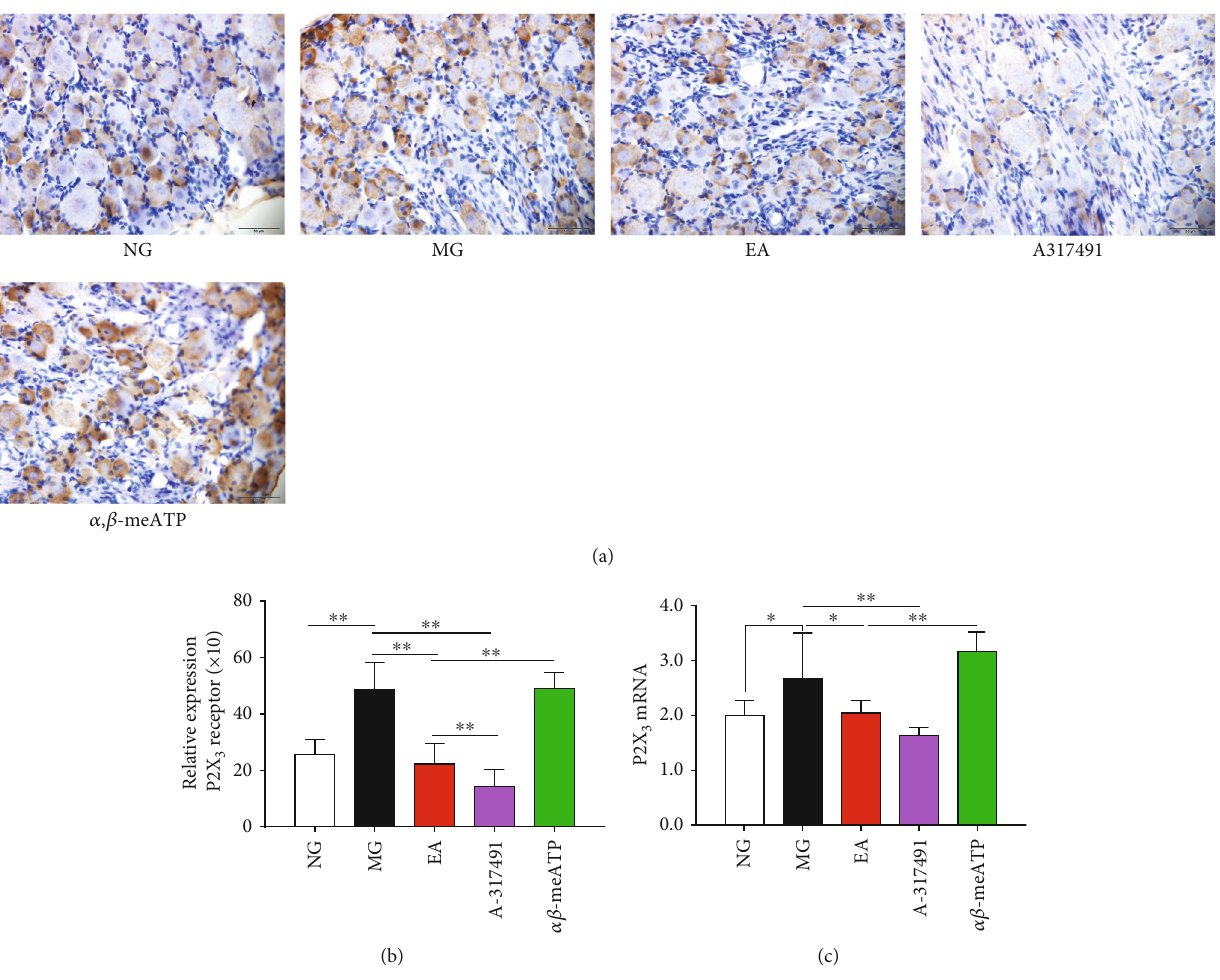
Figure 3: P2X receptor protein and mRNA expression in colon-associated DRG. ( a) Immunohistochemical detection of the distribution of 3 P2X receptor positivity ( n = 6 , scale bar = 50 μ m ). (b). Semiquantitative analysis of the P2X 3 mRNA in DRG ( n = 6 ). ∗ P < 0 : 05 , ∗∗ P < 0 : 01 expression of P2X 3